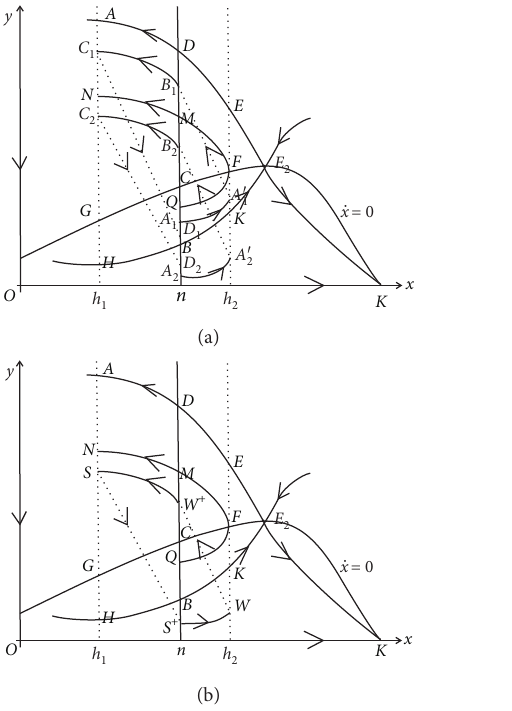
Figure 6: Existence of order-2 periodic orbit of system